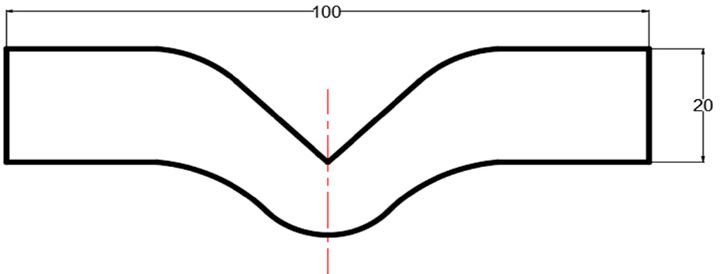
Figure 4. L-shaped specimens. Figure 4. L-shaped